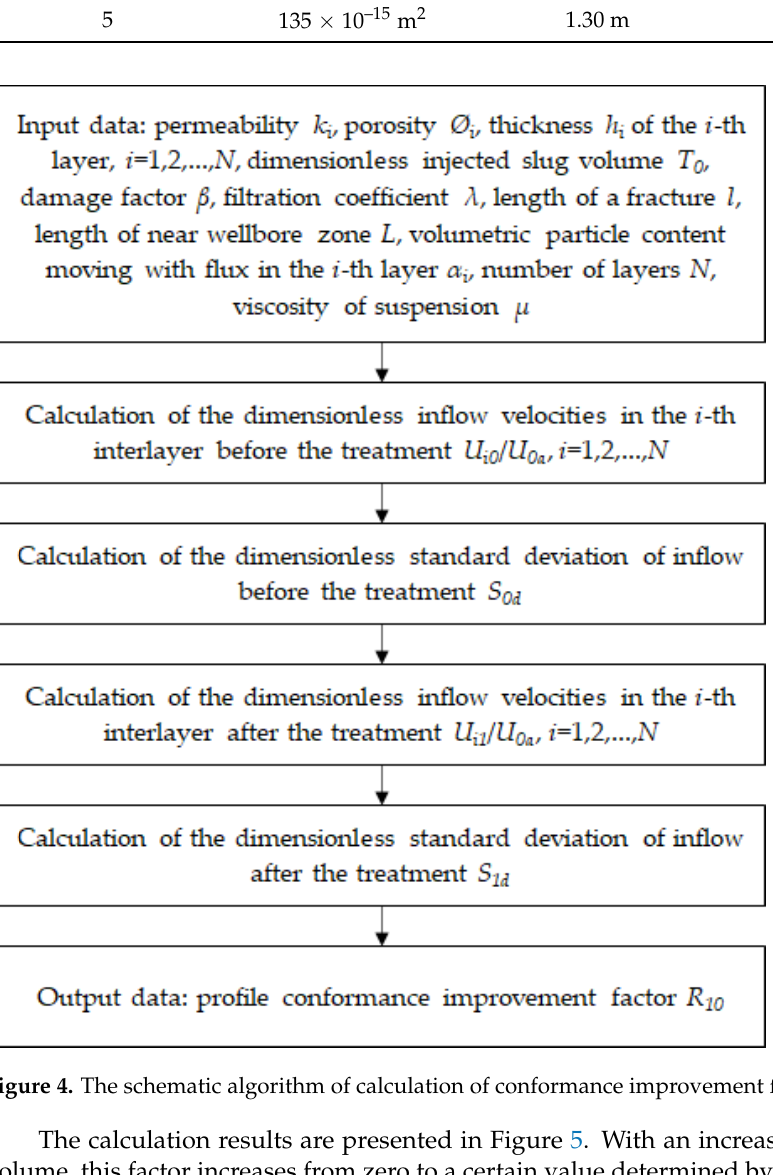
Figure 5. Calculation data on flow profile redistribution R 10 from the dimensionless suspension injected volume T 0 .